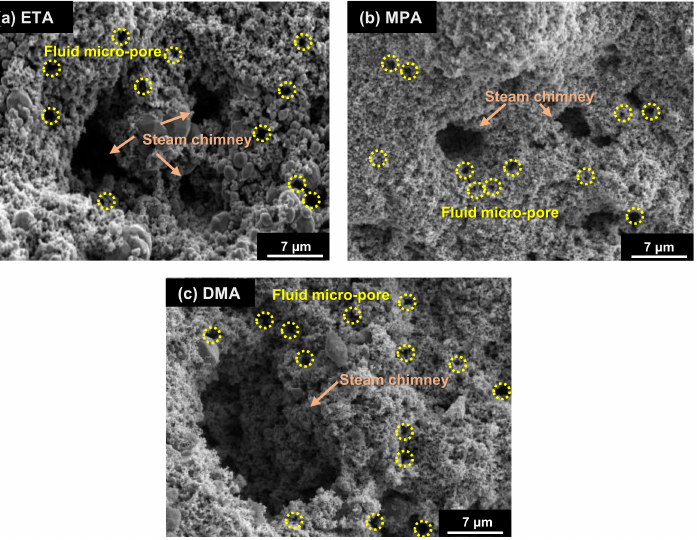
Figure 8. SEM image of steam chimney and fluid micro-pores between magnetite particles on the Alloy 690TT tubes depending on which of the three advanced amines was used: ( a ) ETA, ( b ) MPA, and ( c )